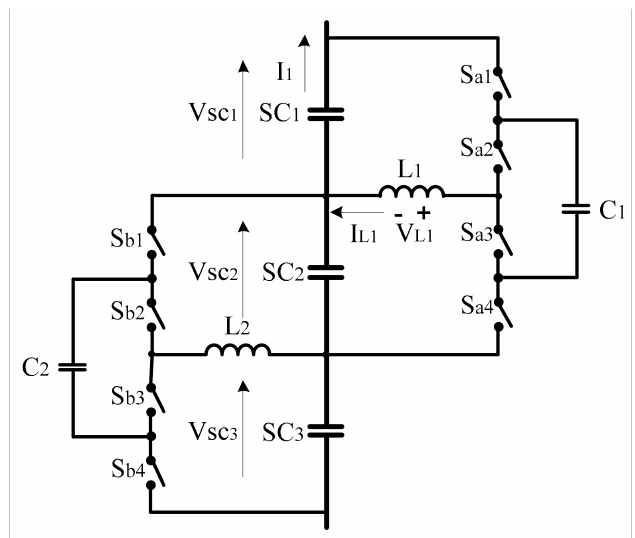
Figure 8. Multi-functional equalizer built in laboratory.